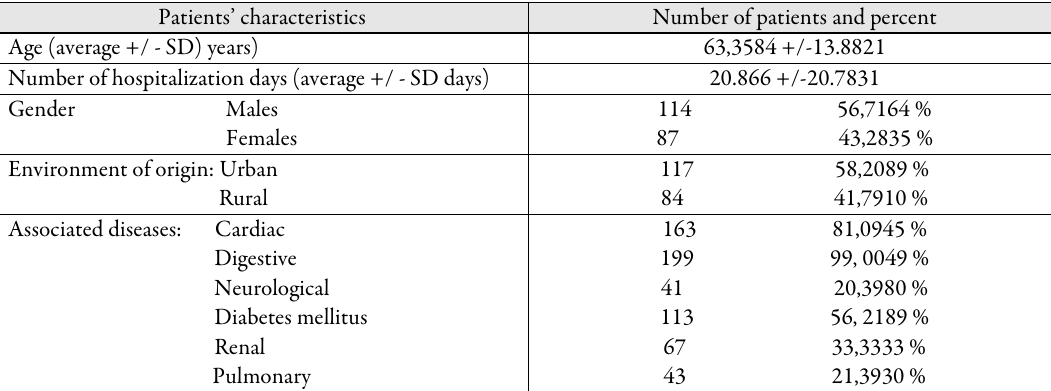
Table Table Table Table 1111. Patients’ characteristics Patients’